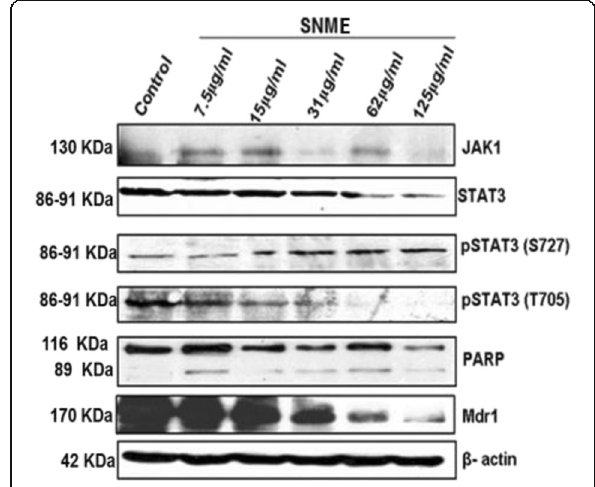
Fig. 5 Western blot analysis of Jak1, Stat3, pStat3 (S727), pStat3 (T705), PARP and Mdr1 protein levels in NCI/ADR-RES cells treated with 7.5, 15, 31, 62 and 125 μ g/ml of SNME for 24 h. β -actin was used to verify equal gel